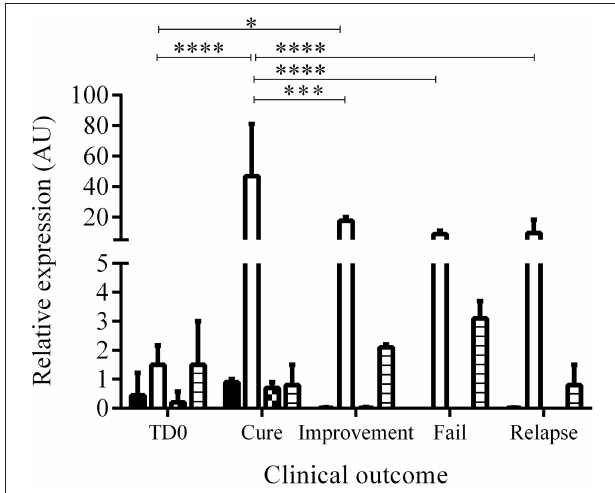
FIGURE 4 | Relative expression of growth factors before and during treatment. The figure shows the induction of growth factors calculated by the 11 CT between TD0 and TD7 method according to the clinical outcome. Bars represent the mean value ± SD. PDGF (black), EGF (white), FGF (square), and TGF β 1 (lines). * p < 0.0413; *** p < 0,0003; **** p < 0.0001, cured ( n = 10), improvement ( n = 24), fail ( n = 27), relapse ( n =